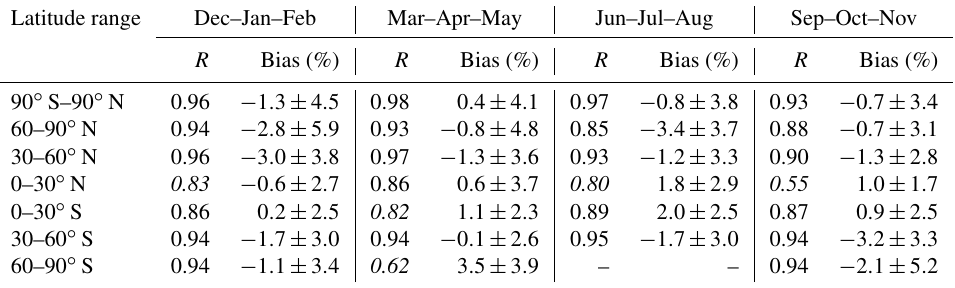
Figure 7. Seasonal distribution of the relative differences (in percent) between IASI-A and GOME-2A total ozone column products for the 2008–2017 period. The relative difference is calculated as 100 × (IASI-A − GOME-2A) / GOME-2A. DJF represents December–January– February, MAM represents March–April–May, JJA represents June–July–August and SON represents September–October–November. Table 2. Summary of the correlation ( R ), the mean bias and the standard deviation values of IASI-A and GOME-2A TOC products computed from daily gridded data, for each season of the 2008–2017 period. The bias and the 1 σ standard deviation are given in percent. The correlation coefficients lower than 0.85 are indicated in